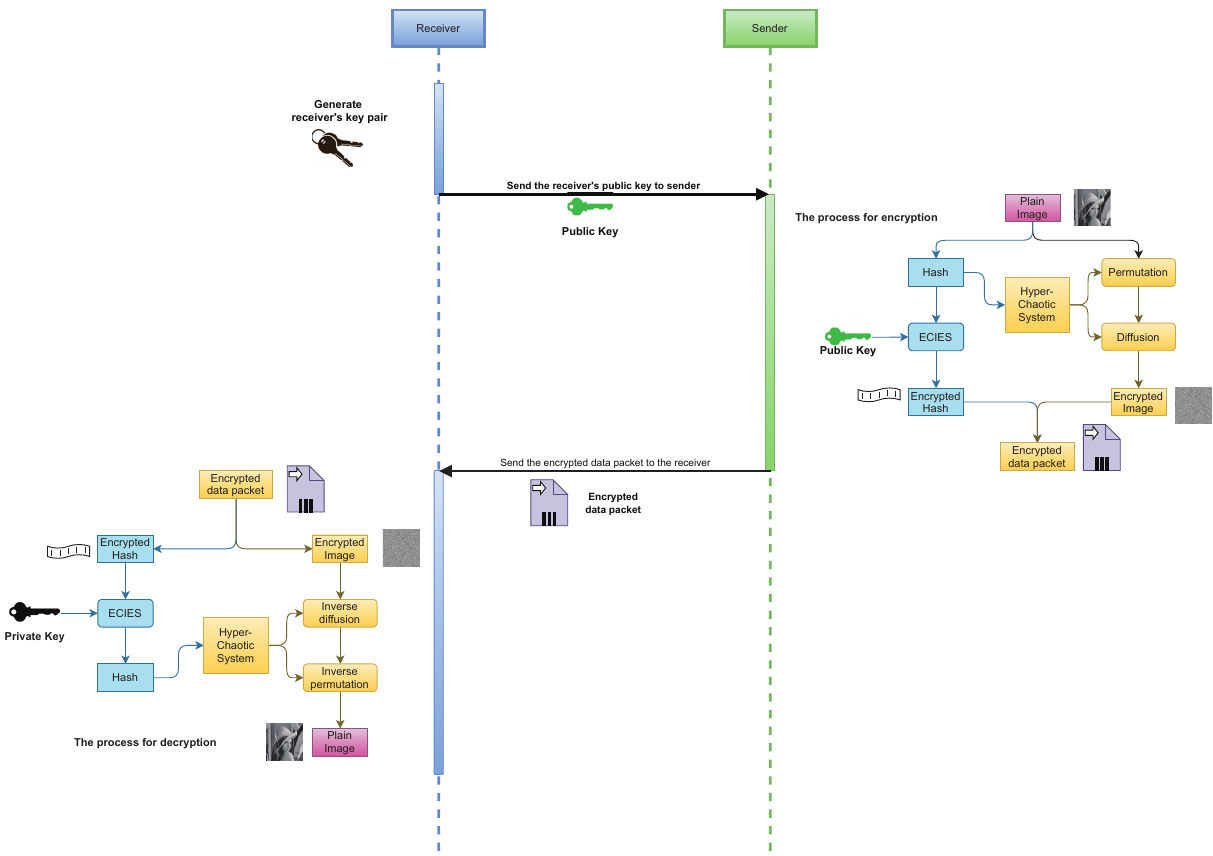
Figure 3. An example for the whole transmission